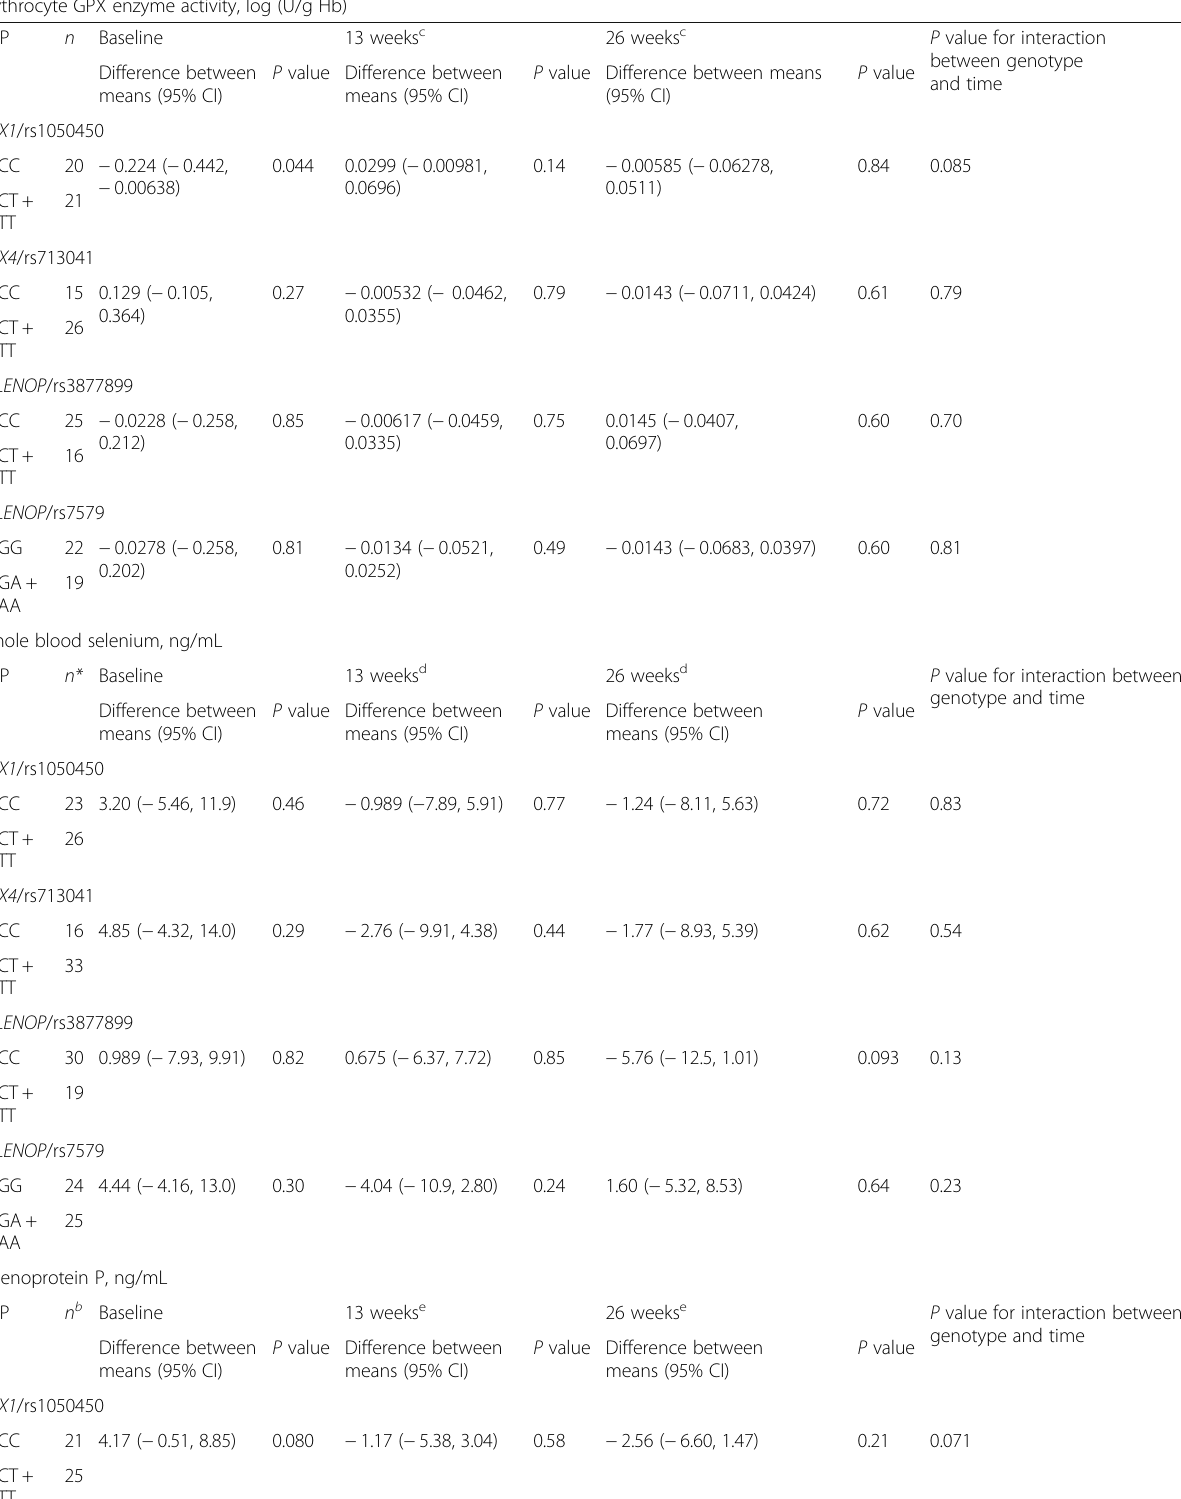
Table 3 Association between mean concentrations of erythrocyte GPX enzyme activity, whole blood selenium, and selenoprotein P in relation to the studied polymorphisms, and within-subject effects between genotype and time in the intervention group Erythrocyte GPX enzyme activity, log (U/g